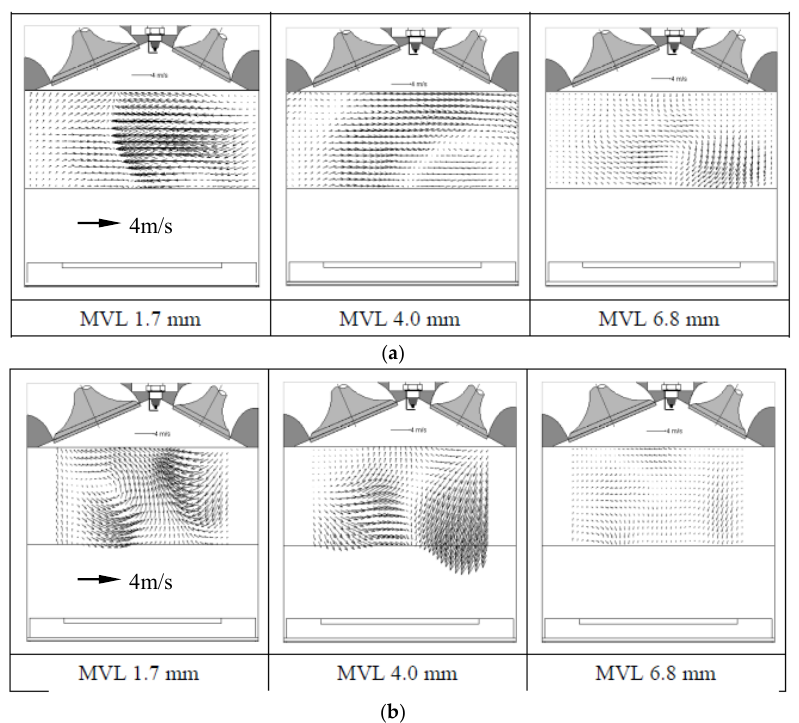
Figure 11. Tumble flow ensemble ‐ averaged flow fields at 128 °CA (during the intake stroke) for MVL 1.7 mm, 4.0 mm and 6.8 mm: ( a ) at Plane 1 and ( b ) at Plane